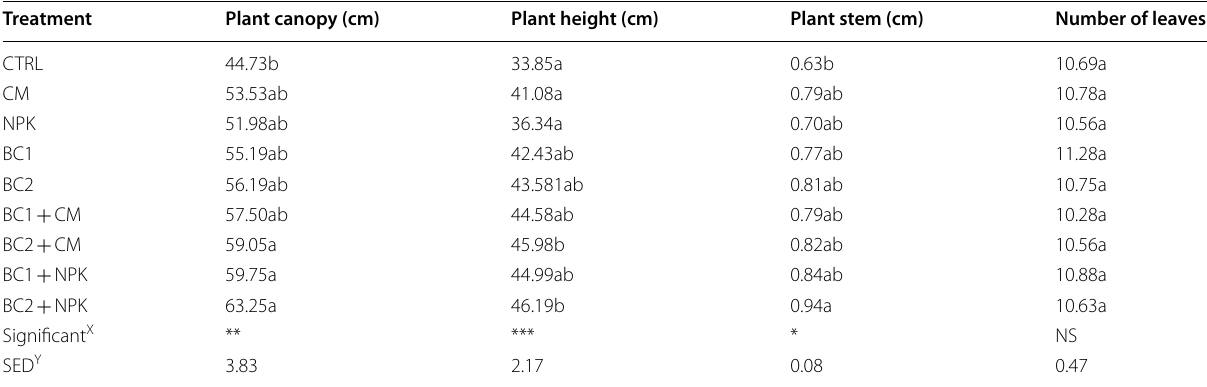
Table 7 Residual effects of co-applied biochar with compost and/or NPK collard plant canopy, plant height, plant stem and number of leaves at 30 DAT